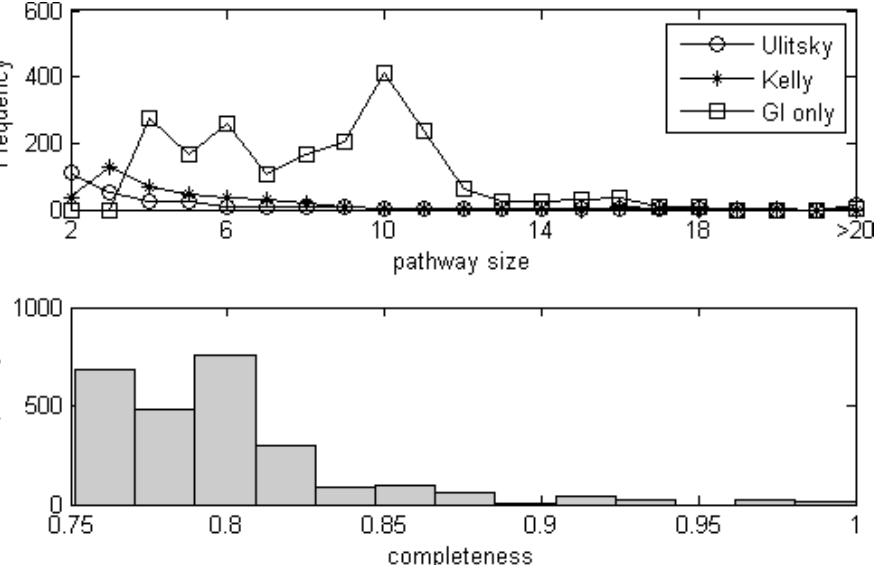
Figure 3. Summary statistics of the pathway pairs we identified. Upper panel: Distribution of the sizes of the pathways of our analysis (GI only; box) and that of Ulitsky and Shamir ([8]; circle) and Kelley and Ideker ([1]; star). Bottom panel: The distribution of the completeness of the between-pathway synthetic lethal interactions in our identified pathway pairs.